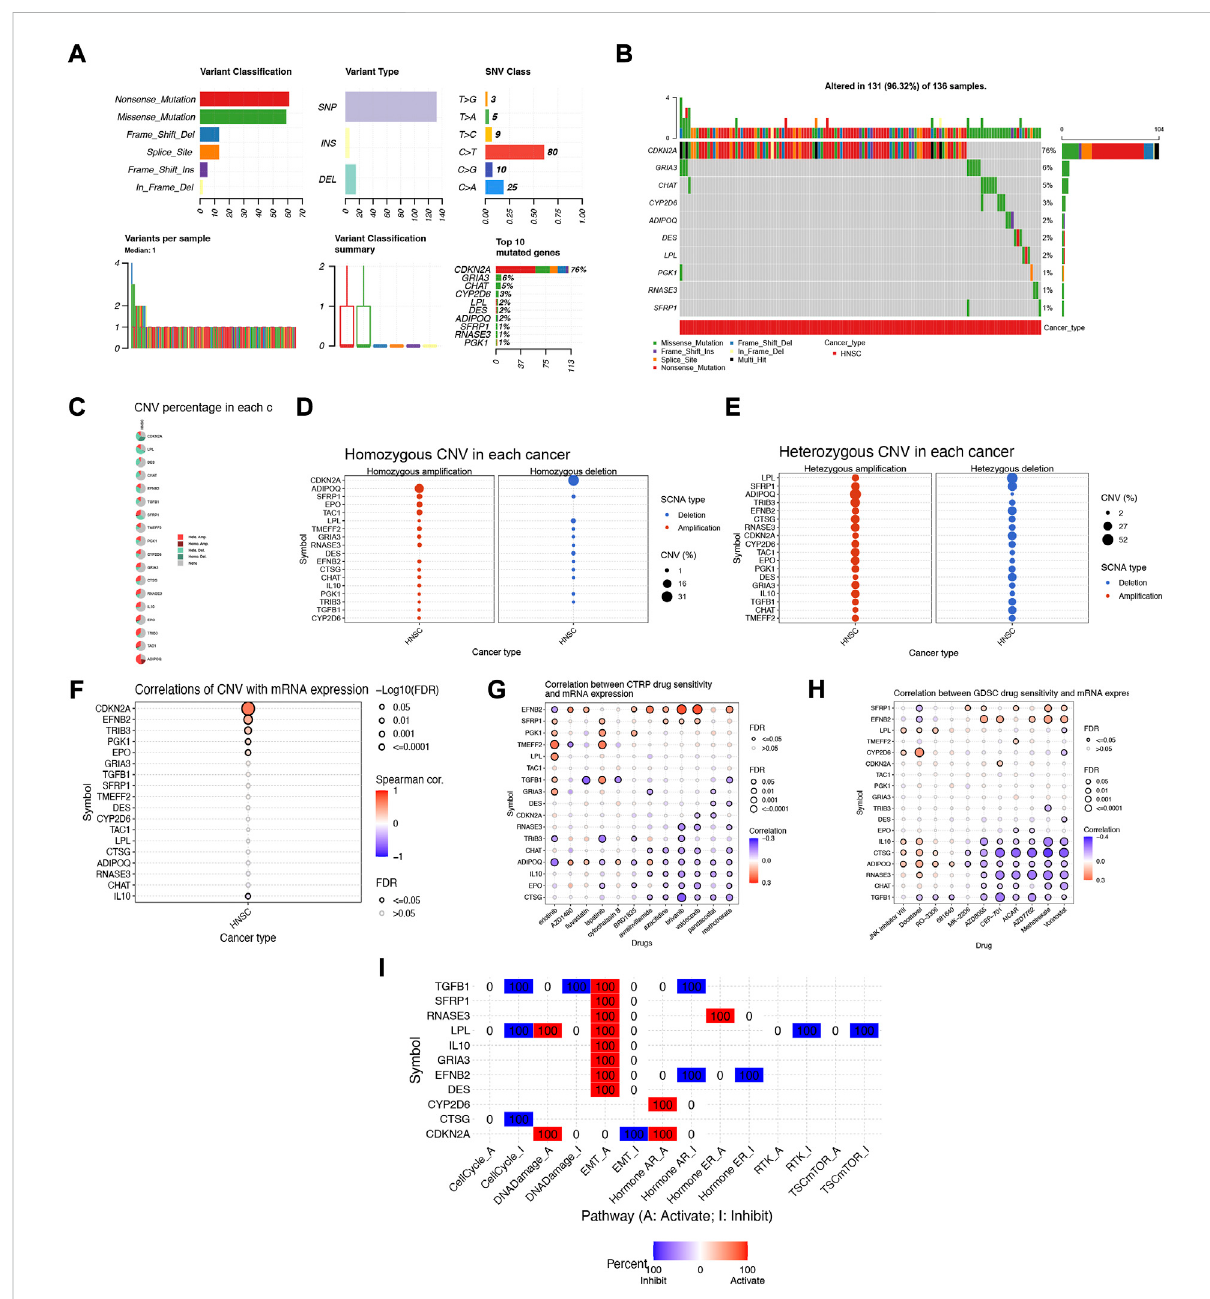
FIGURE 11 Multi-omicsmutationcharacteristicsanddrug sensitivityanalysis ofNFRGs. (A,B) Classi fi cationofmutationsinHNSCC andmutationincidence of NFRGs. (C) The proportion of different types of copy number variation in NFRGs. (D and E) The distribution of copy number variant ampli fi cation and deletion in homozygous mutations versus heterozygous mutations. (F) Correlation analysis of copy number variation and expression of NFRGs. (G,H) Correlation analysis of expression of NFRGs with the sensitivity of chemotherapeutic drugs in CTRP and GDSC cohorts. (I) Analysis of the role of expression activity of NFRGs in the regulation of cancer-related